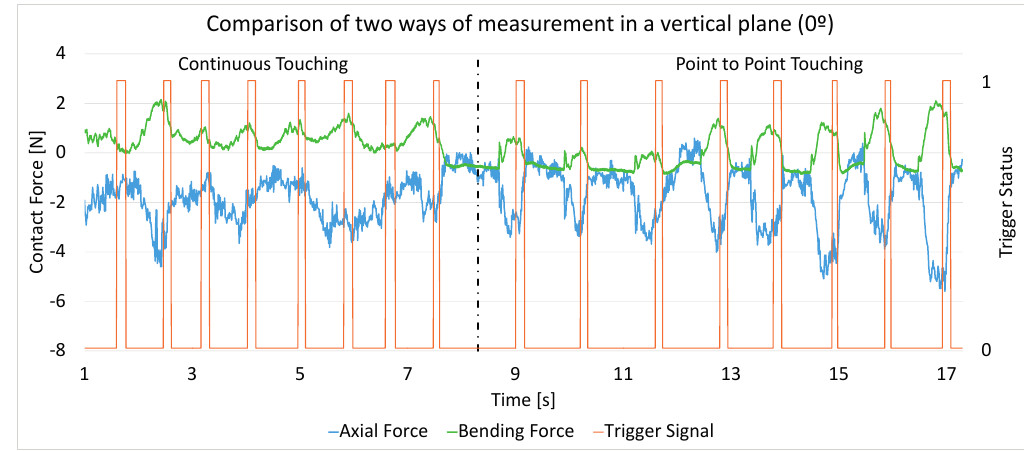
Figure 9. Examples for force reading when measuring different workpieces: continuous touching (left curves) and point-to-point touching (right